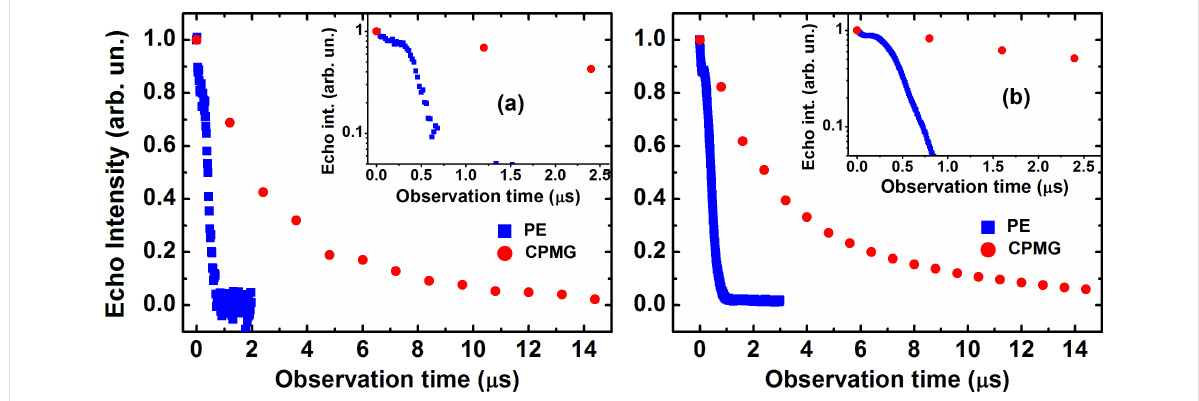
Figure 3: Time dependence of the intensity of the echo signal for complex P1 at T = 30 K on a linear (main panel) and on a logarithmic scale (inset) measured with the primary echo (blue squares) and CPMG (red circles) protocols at X-band (a) and at Q-band (b).